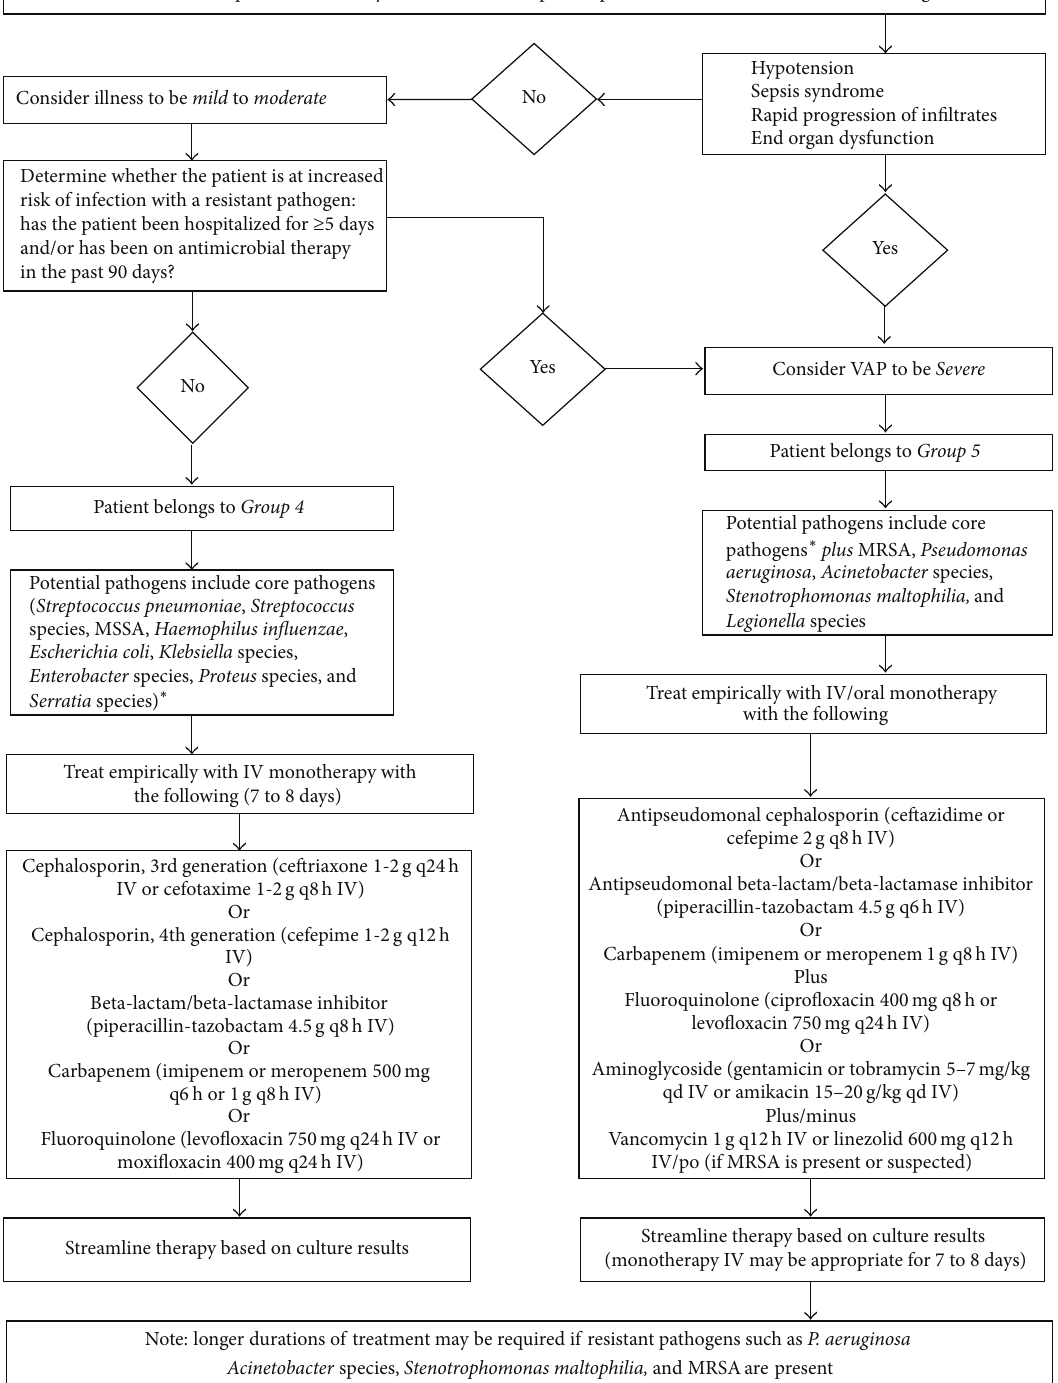
surveillance system with consistent validated